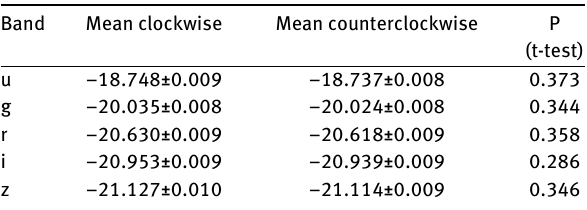
Table 11. Apparent magnitude of clockwise and counterclockwise SDSS galaxies with spectra in the RA range (120 ∘ , 210 ∘ ).